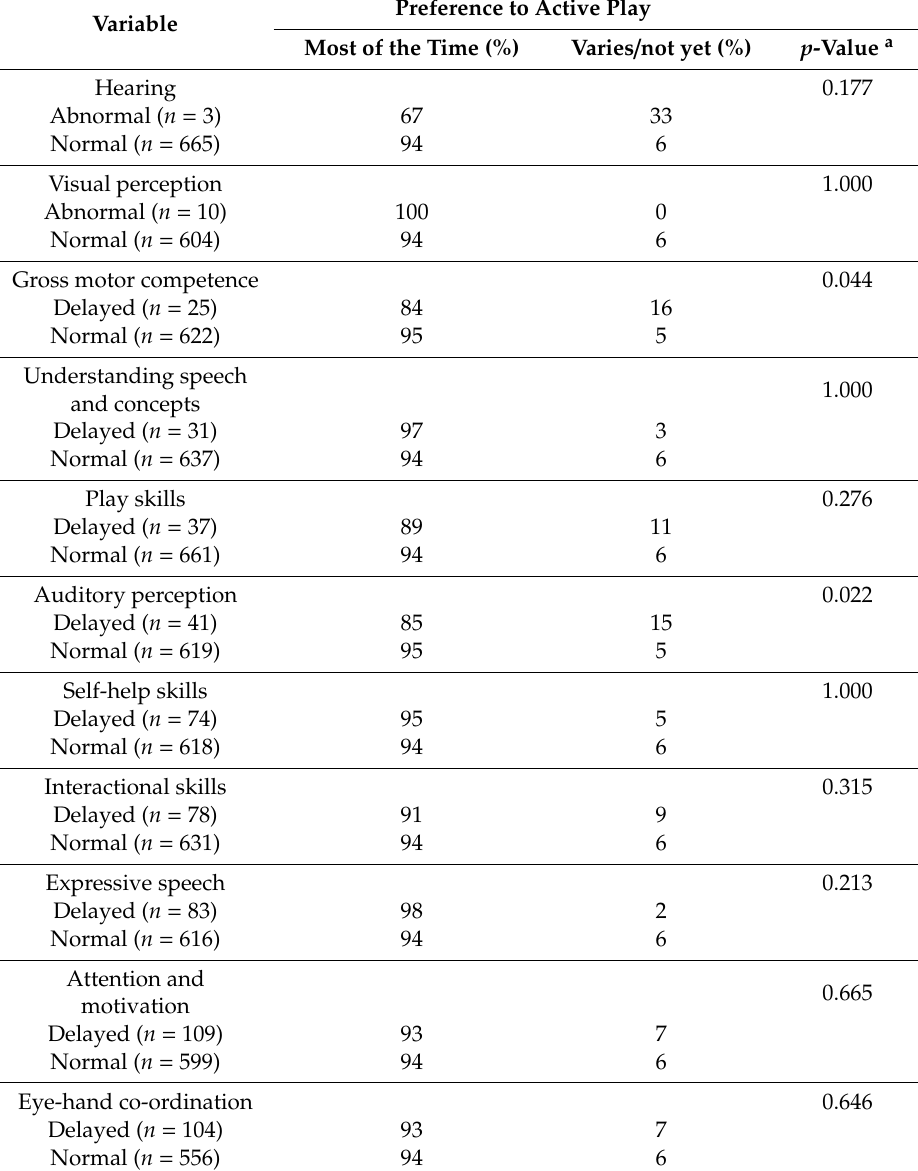
Table 3. The association of the neurological developmental variables with the preference for active play of 2.5-year-old children ( n = 717) at